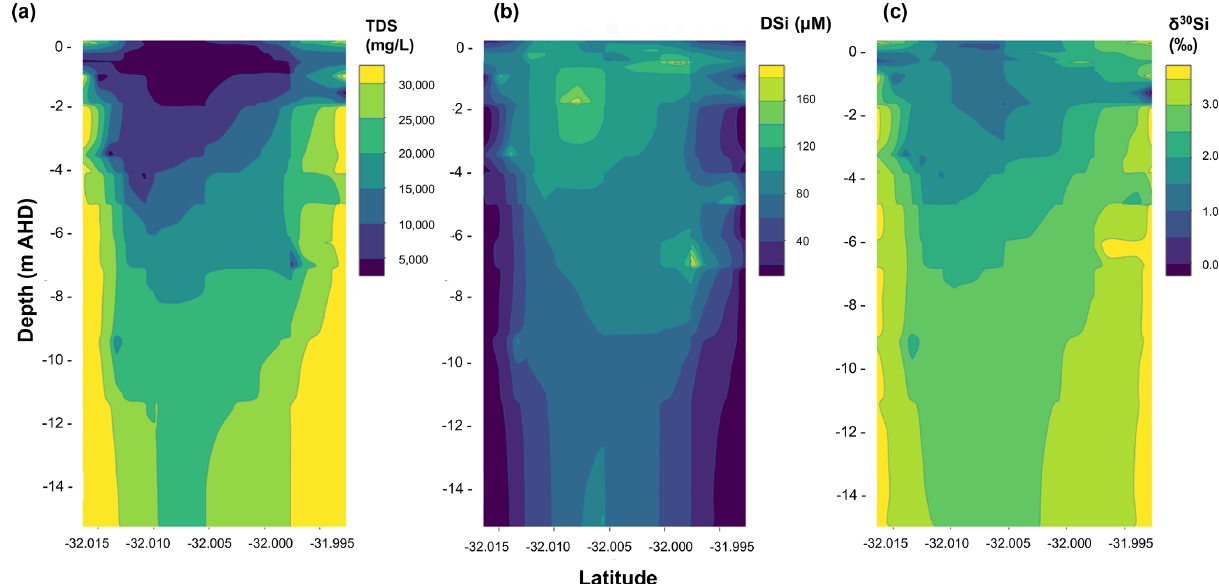
Figure 2. Gridded contour maps for a north–south transect of the aquifer on Rottnest Island, including data from all groundwater samples showing (a) TDS (total dissolved solids) values, (b) dSi concentrations and (c) δ 30 Si values for groundwater as a function of depth and latitude in decimal degrees. The grids were created by interpolating groundwater data from their coordinates and depth using the loess function in the base package of the statistical programming language R, which is a non-parametric approach that fits multiple regressions within a given